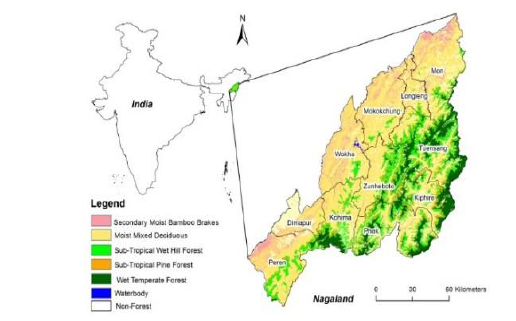
Fig.1. Study area location and forest types distribution in study